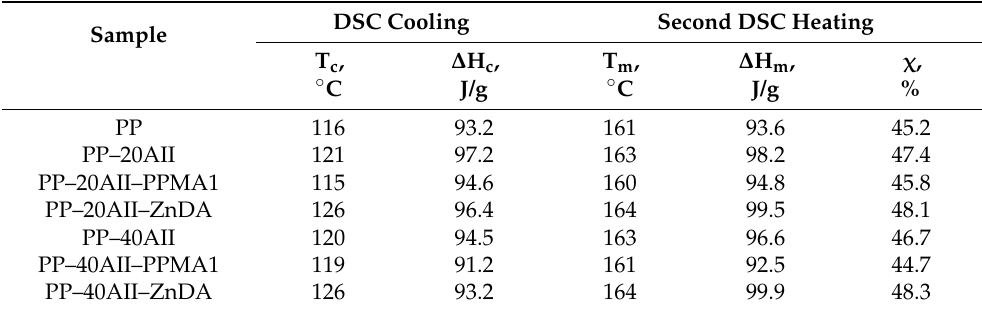
Table 3. Comparative DSC data of PP and PP–AII composites obtained during non-isothermal crystallization from the molten state and following the succeeding heating scan (DSC cooling and second heating by 10 ◦